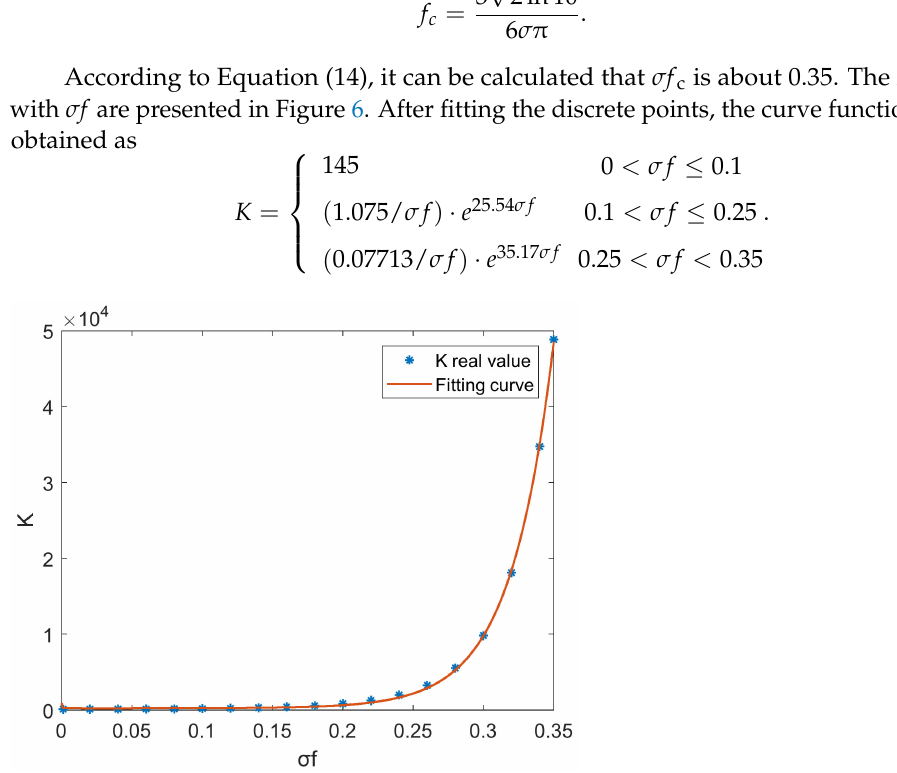
Figure 6. The K values with σ f and the fitting curve. Substitution of Equation (15) and B =